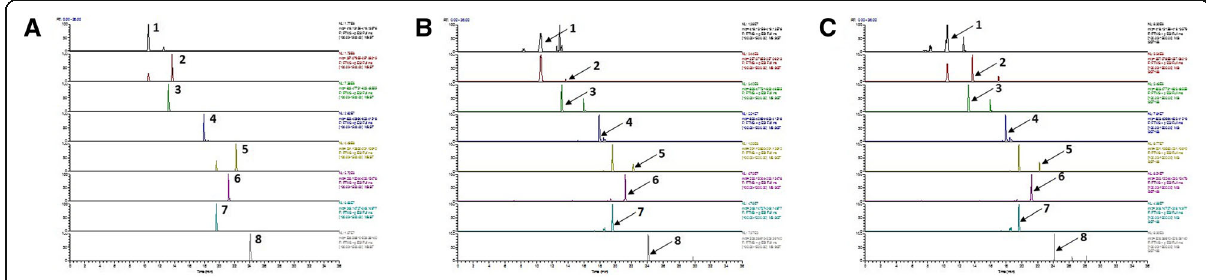
Fig. 3 Extracted ion chromatogram (EIC) of standard mixture ( a ), SGT ( b ) and SGT166 ( c ) using UPLC-ESI-MS analysis. 1 , Liquiritin; 2 , Liquiritigenin; 3 , Ginsenoside Rg 1 ; 4 , Glycyrrhizin; 5 , Atractylenolide Ι ; 6 , Atractylenolide II; 7 , Atractylenolide III; 8 , Pachymic